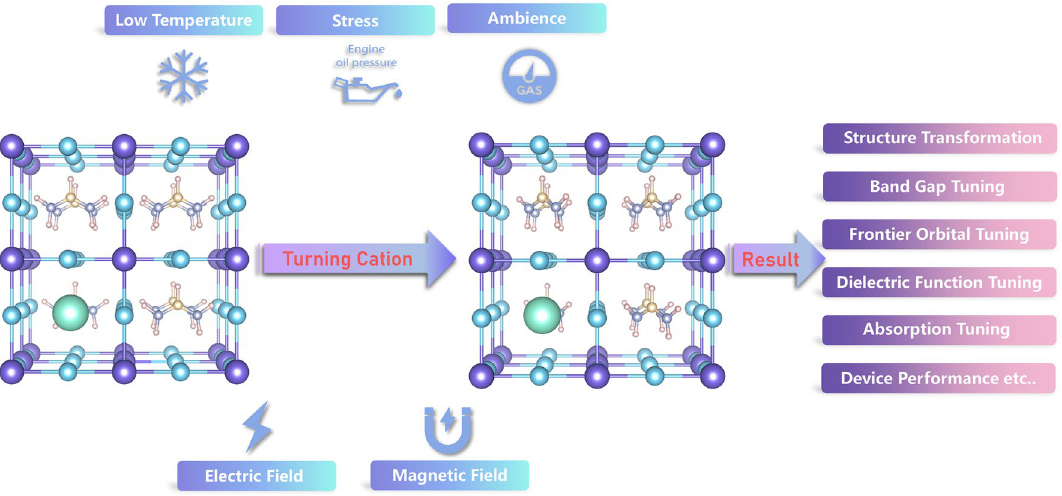
Figure 1. Schematic diagram of possible ways to change the orientation of organic cation and the result lead by